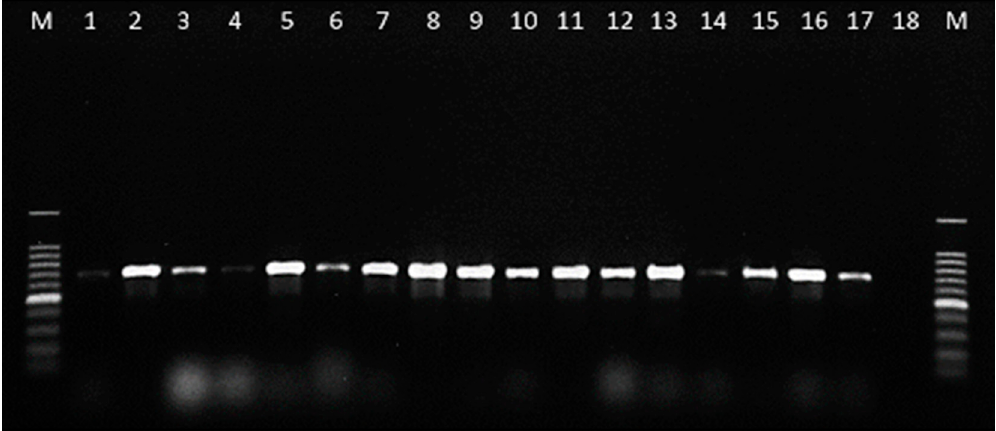
Figure 2. Specificity of PCR using the primer pair CLF (5 ′ -CCCGAGAAGGCTCCAAGTA-3 ′ )/CLR (5 ′ - (5 (cid:48) -CATAAACGCCTAAGAACCGC-3 (cid:48) ) on 17 isolates of C. lupini (Lane 1–17). Lane 18 = negative CATAAACGCCTAAGAACCGC-3 ′ ) on 17 isolates of C.lupini (Lane 1–17). Lane 18 = negative control control (without DNA), Lane M = 100 bp DNA ladder. (without DNA), Lane M = 100 bp DNA ladder.